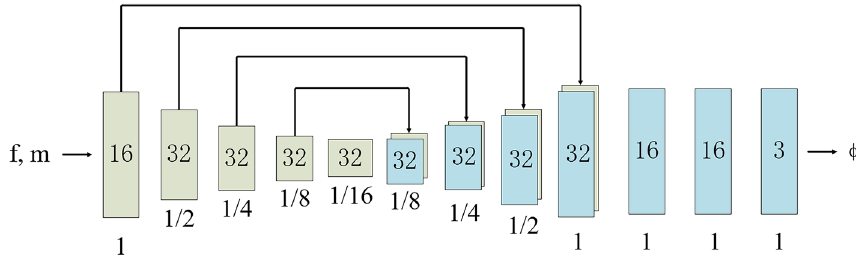
Figure 1. CNN architecture implemented gθ (f, m). Each rectangle represents a 3D volume, generated from the preceding volume using a 3D convolutional network layer. The spatial resolution of each volume with respect to the input volume is printed